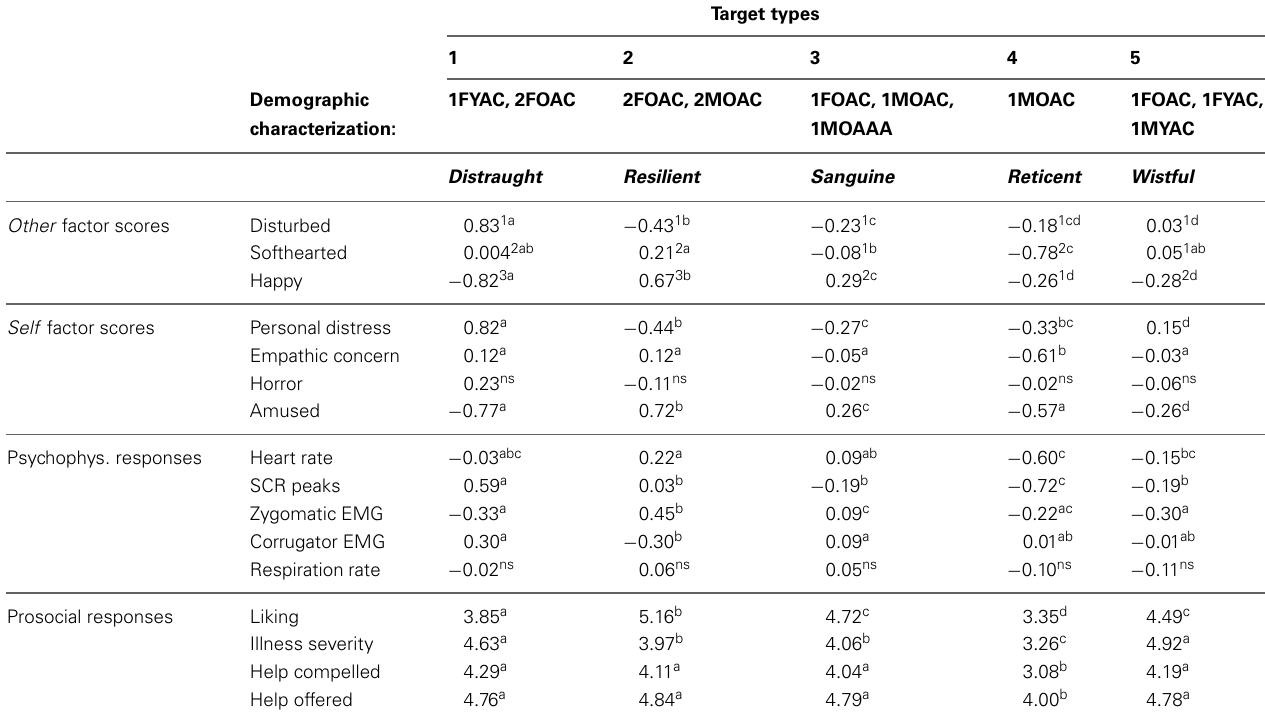
Table 1 | Mean factor scores, psychophysiological (psychophys.) responses, and ratings by target type in Study